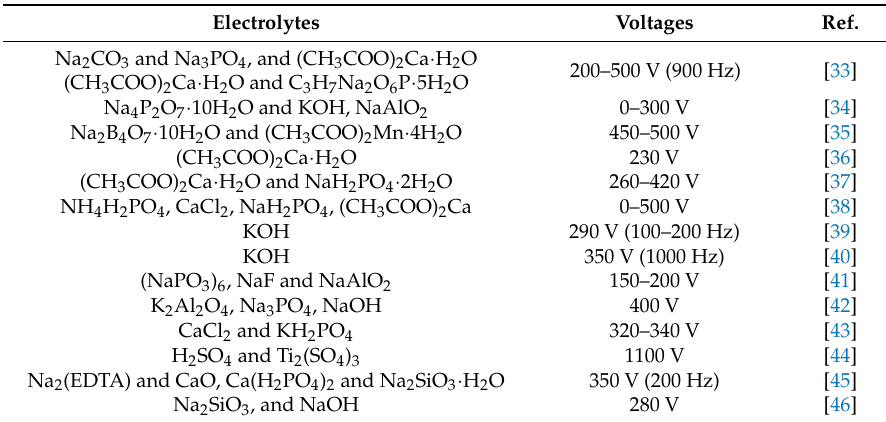
Table 1. Examples of aqueous electrolytes used in plasma electrolytic oxidation (PEO) treatment with voltage